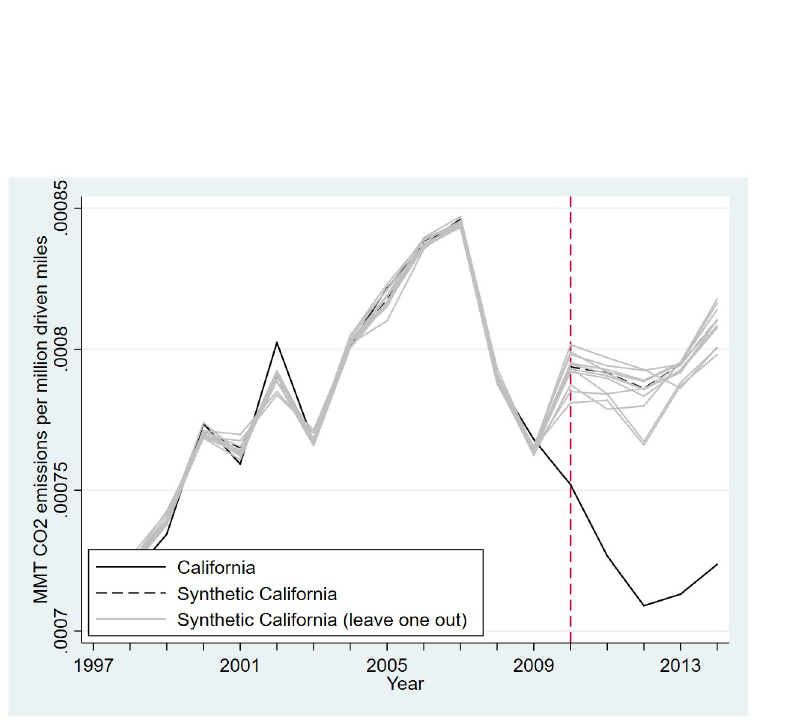
Fig 5. Leave-one-out test of the synthetic control estimation to measure the effect of the LCFS on emissions.